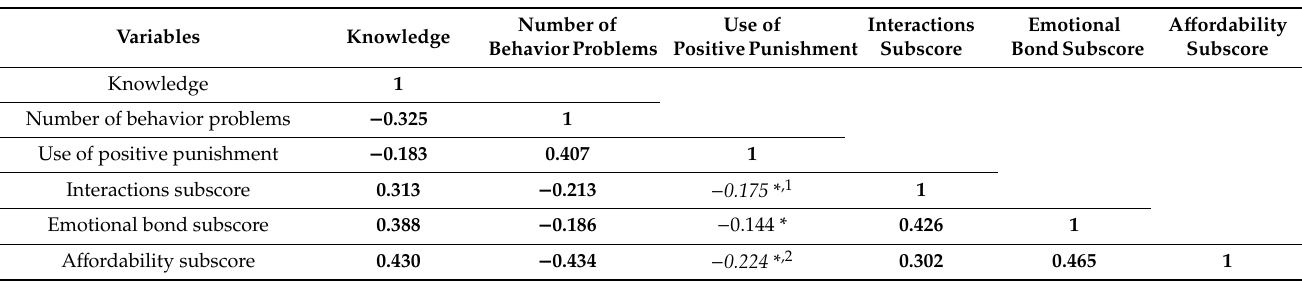
Table 4. Correlation matrix for knowledge score (higher score reflects more accurate understanding of cat behavior), number of behavior problems reported by owner, use of positive punishment-based responses to perceived misbehavior (higher score indicates more punishment used) and three bond-related measures: interactions (between owner and cat), emotional bond, and a ff ordability. Bond subscores were adapted from Howell et al. (2017) [9]. For the three bond-related subscores, a higher score reflects a more positive relationship with the cat (e.g., a lower ‘a ff ordability’ score meant that the owner was more bothered by the costs associated with caring for their cat). Bold font indicates that the correlation is significant from 0 at p < 0.0001; italic font indicates that the correlation is significant but at a di ff erent level; see footnotes for these p values.